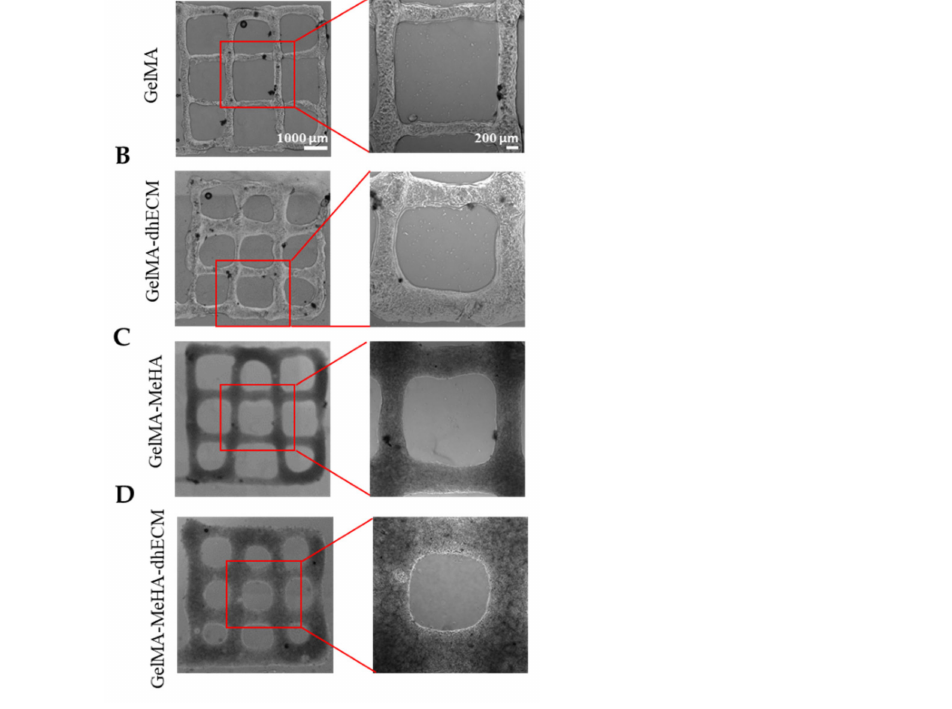
Figure 4. Brightfield images of 3D printed 2 layered-grid constructs using ( A ) GelMA, ( B ) GelMA– dhECM, ( C ) GelMA–MeHA, ( D ) GelMA–MeHA–dhECM hydrogels ( n ≥